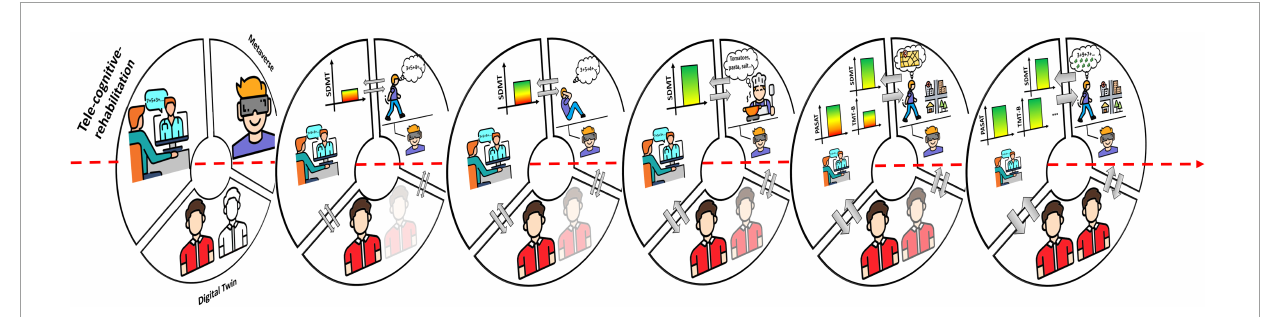
FIGURE2 Integration and development of the three digital ingredients. The three digital ingredients represent different sources of data that can be integrated. Over time, the increasing exchange of the data between the different data sources (gray arrows) will feed the AI algorithms that, in turn, will enhance the cognitive phenotyping and provide increasingly defined digital twins. At the same time, the rehabilitative protocols delivered through the tele-cognitive-rehabilitation platform will be increasingly tailored, eventually in a (semi-)automatic way, with a corresponding improvement of the treatment effects (e.g., firstly IPS improved and, then, also other cognitive domains). In the metaverse, the complexity of the tasks increases toward training cognitive functions in more ecological environments and improve the performances transfer into everyday life activities. This figure has been designed using modified free images from